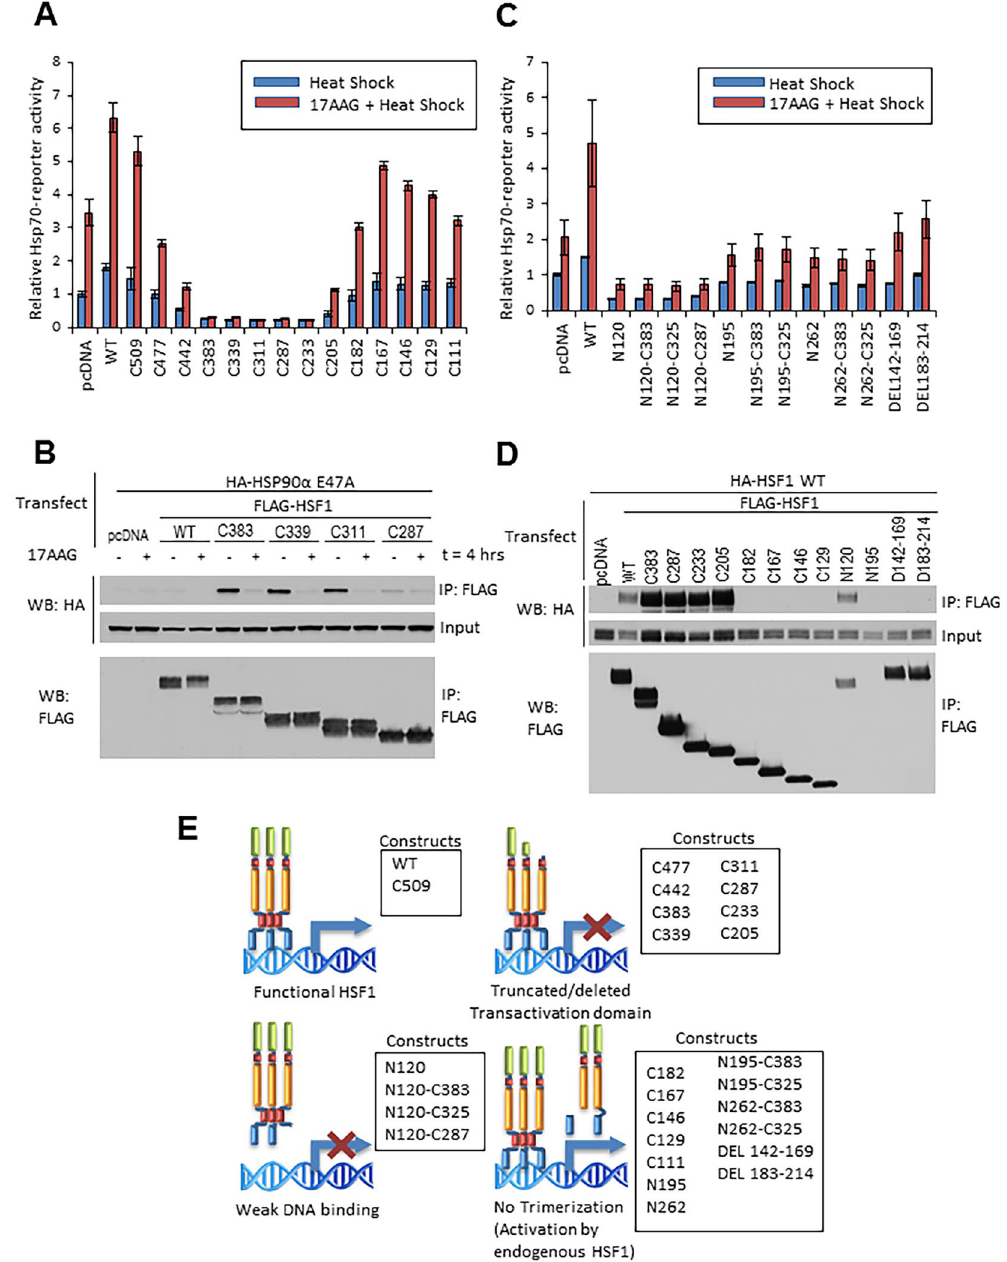
Figure 3. Effects of HSF1 truncation and internal deletion mutants on hsp70 promoter-reporter activity and HSF1 dimerization. ( A ) Expression of TAD-deleted HSF1 constructs inhibits endogenous HSF1 driven hsp70 promoter-reporter activity, while removal of the HR-A/B domain abrogates dominant negative activity. HEK293 cells were transfected with hsp70 promoter-reporter construct and HSF1 C-terminal truncation constructs, treated with DMSO or 17AAG for 1 hour, heat shocked at 42 °C for 30 minutes and allowed to recover for 4 hours before harvesting. ( B ) Disruption of HA-tagged HSP90 α E47A interaction with HSF1 C-terminal RD truncations by 17AAG. HEK293 cells were transfected with HA-HSP90 α E47A and FLAG-HSF1 RD truncation mutants, then analyzed by anti-FLAG (HSF1) IP followed by HA (HSP90 α E47A) WB. Pull-down experiments were repeated at least twice. ( C ) Deletion of the DBD and retention of the HR-A/B domain inhibits hsp70 -reporter activity driven by endogenous HSF1. HEK293 cells were transfected, treated and processed as described in panel A. ( D ) Deletion of the HR-A/B domain disrupts HSF1 dimerization. HEK293 cells were transfected with WT HA-HSF1 and FLAG-HSF1 deletion constructs, then analyzed by anti-FLAG IP and HA WB. Pull-down experiments were repeated at least twice. ( E ) Summary of the effects of HSF1 domain deletions on hsp70 -reporter activity. Full blots used to create cropped figure panels are shown in Supplementary Figure